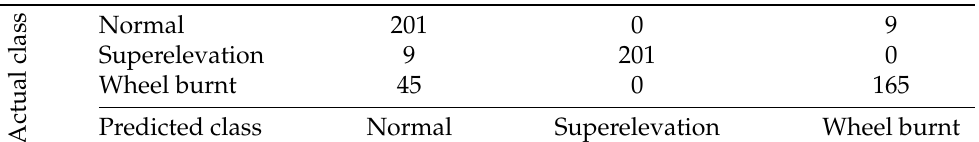
Table 9. Confusion matrix of LSTM 8.5 s split, un-augmented training dataset and augmented test dataset.